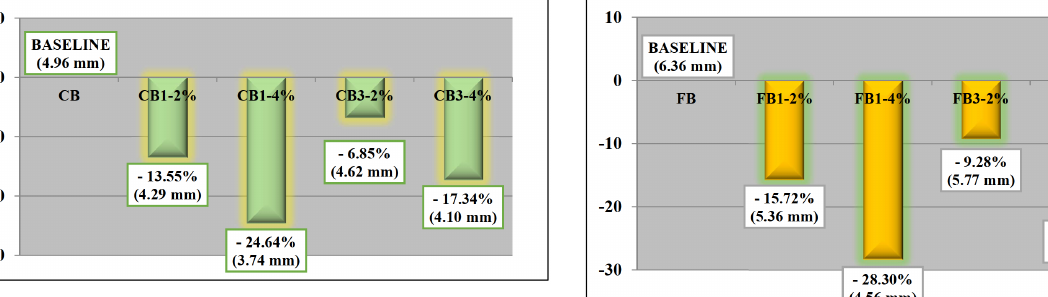
Figure 4: Vertical deformation of clean-ballast based specimen after the first loading CB3-4%) and fouled-ballast based specimens (FB1-2%, FB1- 4%, FB3-2%, FB3-4%) which were added with 2% and 4% penetration grade 60/70 asphalt have lower vertical defor- mation as compared to each baseline specimen (CB and FB). This result is in agreement with D’Angelo et al. [4] and Setiawan et al. [26].